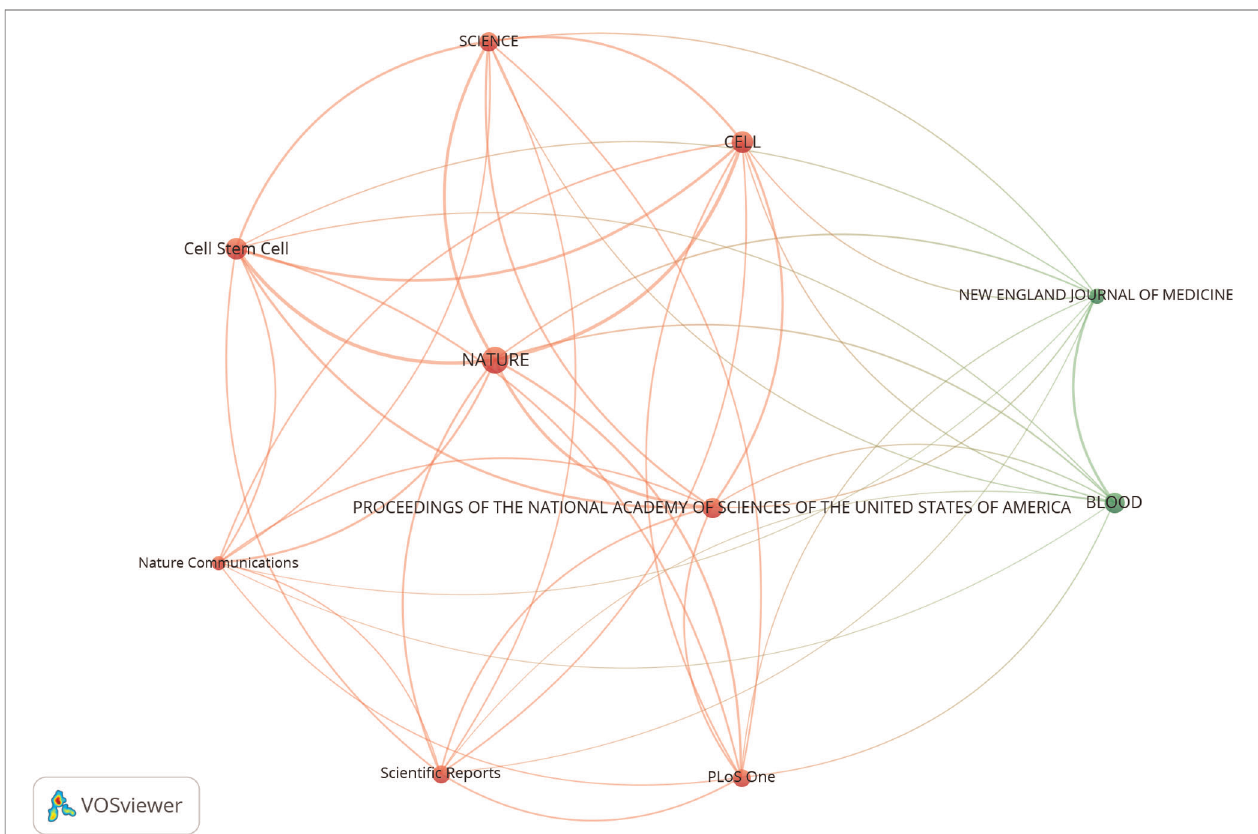
FIGURE 3 | Co-citation relationships among journals related to stem cell precision medicine research. The circles represent journals, with the larger circle corresponding to more citations. The connecting lines represent the co-citation relationship between journals, with the thicker line corresponding to more co- citations. Different colors represent different clusters automatically calculated by